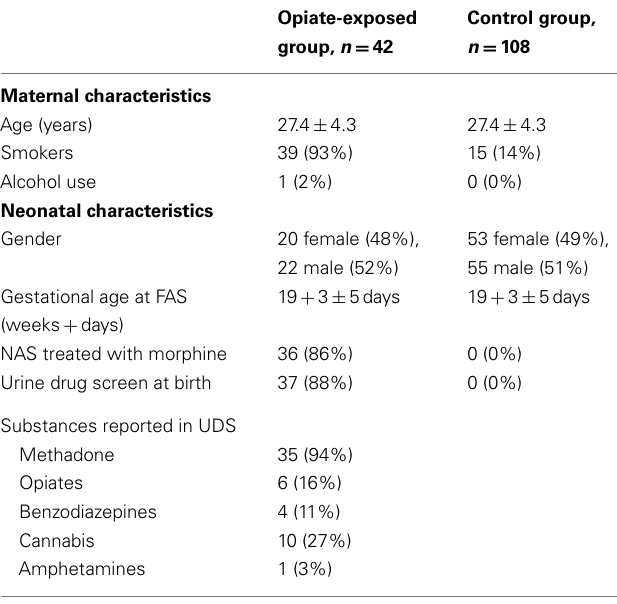
Table 1 | Maternal and neonatal characteristics